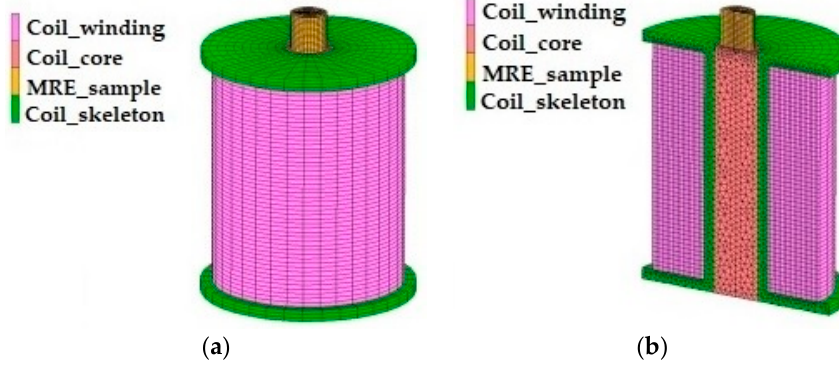
Figure 3. ( a ) Magnet with MRE sample and ( b ) cross section view of magnet with core, skeleton, coil winding, and MRE sample position.